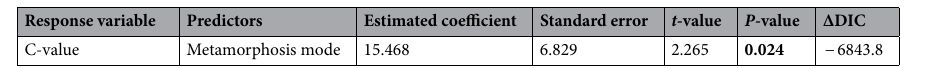
Table 3. Generalized linear mixed effects model results of metamorphosis mode as a predictor of genome size (C-value) of aquatic macroinvertebrates with order set as a random variable. ΔDIC: Difference